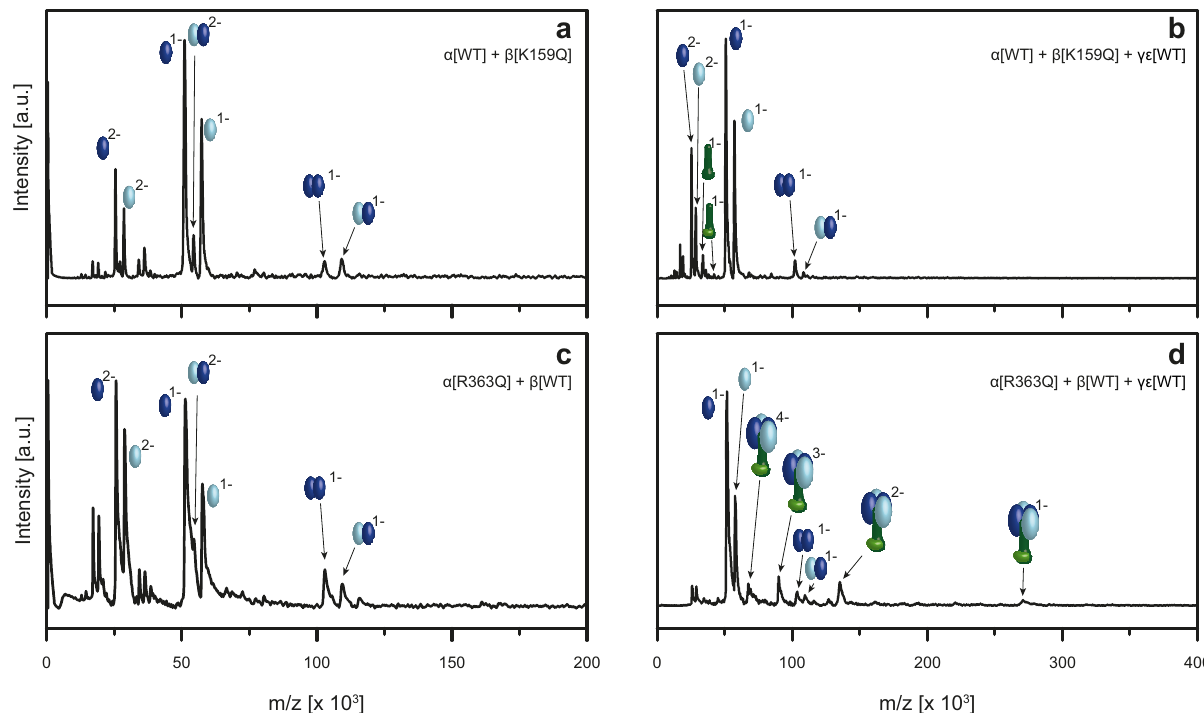
Fig. 7 Role of charged residues in the catalytic site for the assembly process analyzed by LILBID-MS. a In vitro assembly of α [WT] (light blue) with β [K159Q] mutant (dark blue) shows no signi fi cant formation of the αβ heterodimer, which we observe for the α [WT] and β [WT] (Fig. 1b). b The addition of the central stalk γε (dark and light green) does not lead to the formation of the desired α 3 β 3 γε complex. c In vitro assembled α [R363K] (light blue) and β [WT] (dark blue) revealed reduced αβ heterodimer assembly. d The biggest complex that is observed after addition of γε (dark and light green) is an α β γε subcomplex with charge states ( − 1 to − 4). Source data are provided as a Source Data fi 2 2